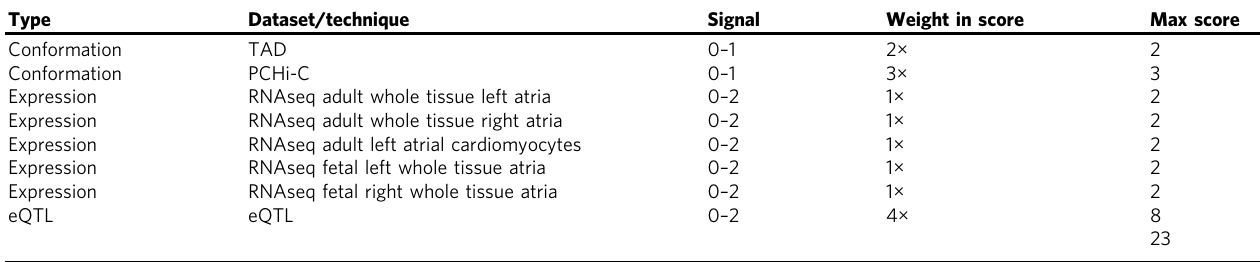
Table 1 Scoring calculation method AF target genes